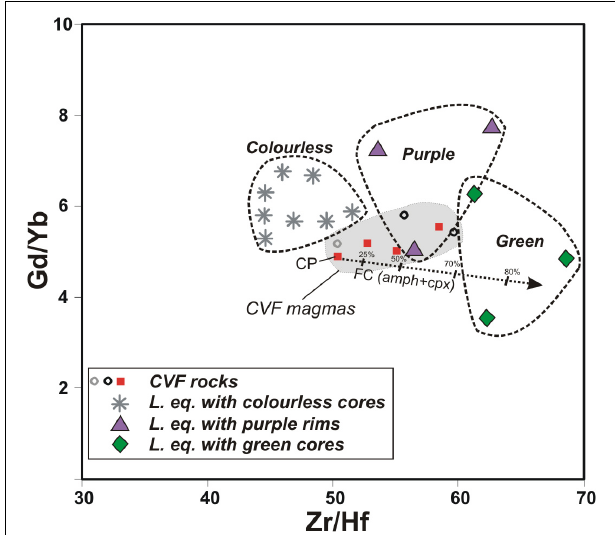
FIGURE 13 | Gd/Yb vs Zr/Hf ratios of melts equilibrated with clinopyroxenes. The compositional field of Calatrava Volcanic Field (CVF) magmas is also shown for comparison. The clinopyroxene compositions used for calculations are averaged values for selected colorless megacrysts (115603, 114404, 111639) and phenocryst cores (115605, 116596), together with green phenocryst cores (116596) and pyroxenites (115601, 115591). Purple rims overgrow phenocrysts (115605, 116596) and pyroxenite crystals (115591) (see Supplementary Table S2 for averaged clinopyroxene values). The C 0 for the fractional crystallization model is the CAL-73 nephelinite (from the Cerro Pelado volcano, CP in figure). The arrow represents the trend of chemical evolution of melts based on the fractionation model (up to 80% of fractional crystallization) considering extraction of 45% clinopyroxene + 45% amphibole + 10%